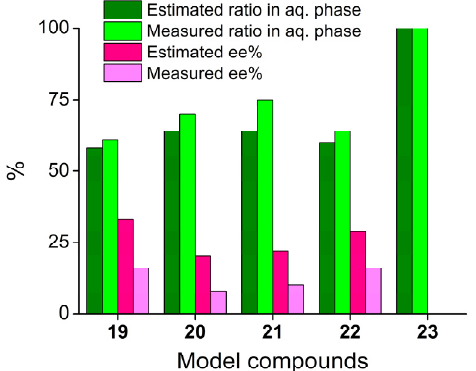
Figure 4. Validation of the method for enantioenrichment of racemic mixtures by using DBTA-12 ( 17 ) as a liquid membrane (incubation = 60 min; ratio in the aqueous phase was estimated by averaging the distributions of the isolated enantiomers obtained from studies on separability).